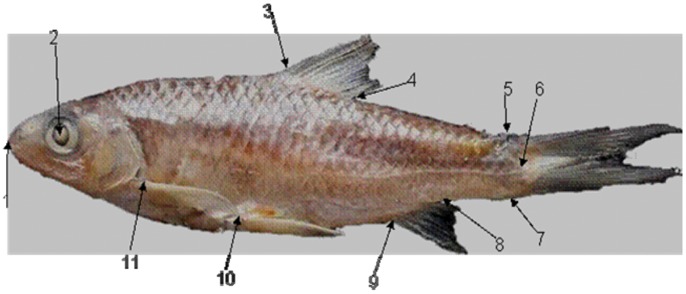
Locations of landmarks on the body surface of P. huangchuchieni.
Note: 1: Tip of the mouth, junction of premaxilary and ethmoid; 2: Center of eyes; 3: Former basal point of dorsal fin; 4: Posterior basal point of dorsal fin; 5: Upper basal point of tail fin; 6: Centre basal point of tail fin; 7: Abdominal basal point of tail fin; 8: Posterior basal point of anal fin; 9: Former basal point of anal fin; 10: Former basal point of ventral fin; 11: Former basal point of pectoral fin.